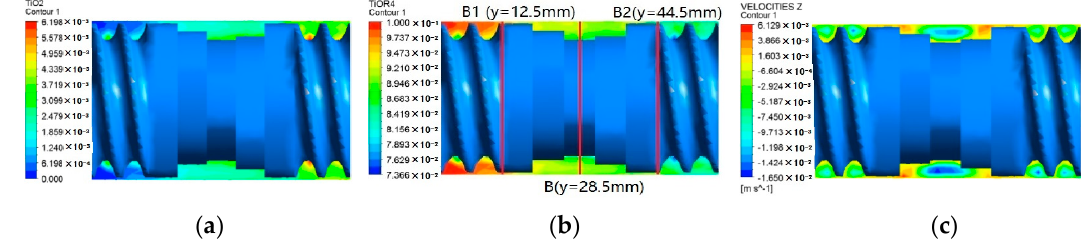
Figure 7. Contours of different fields at cross plane C: ( a ) product; ( b ) reactant; ( c ) axial velocity.